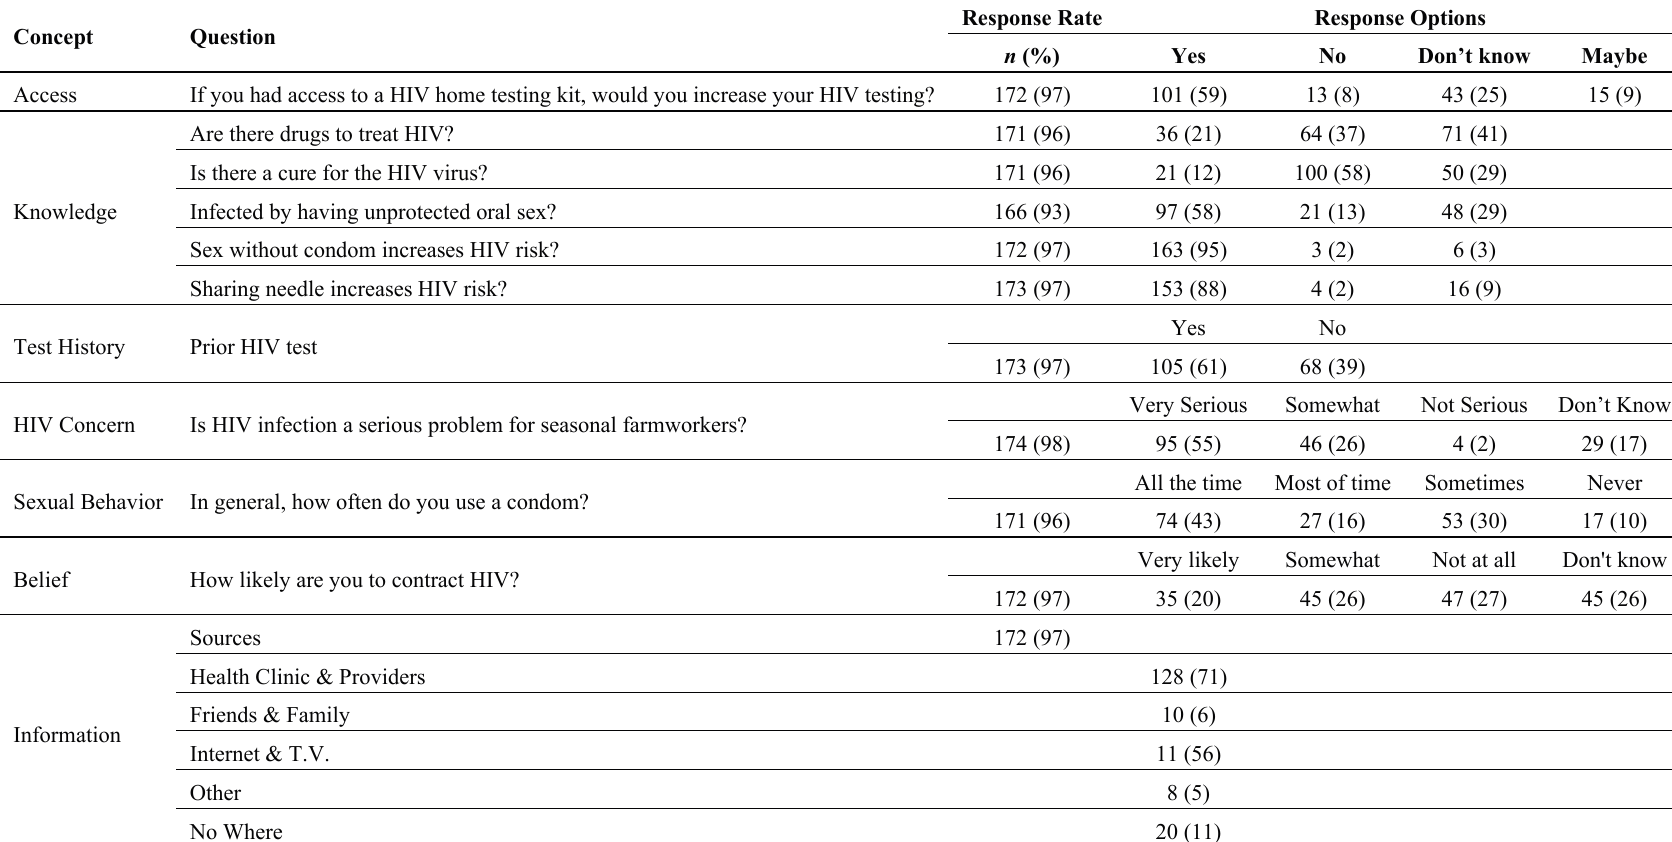
Table 1. Knowledge and beliefs of HIV disease among 178 Latino male farmworkers, North